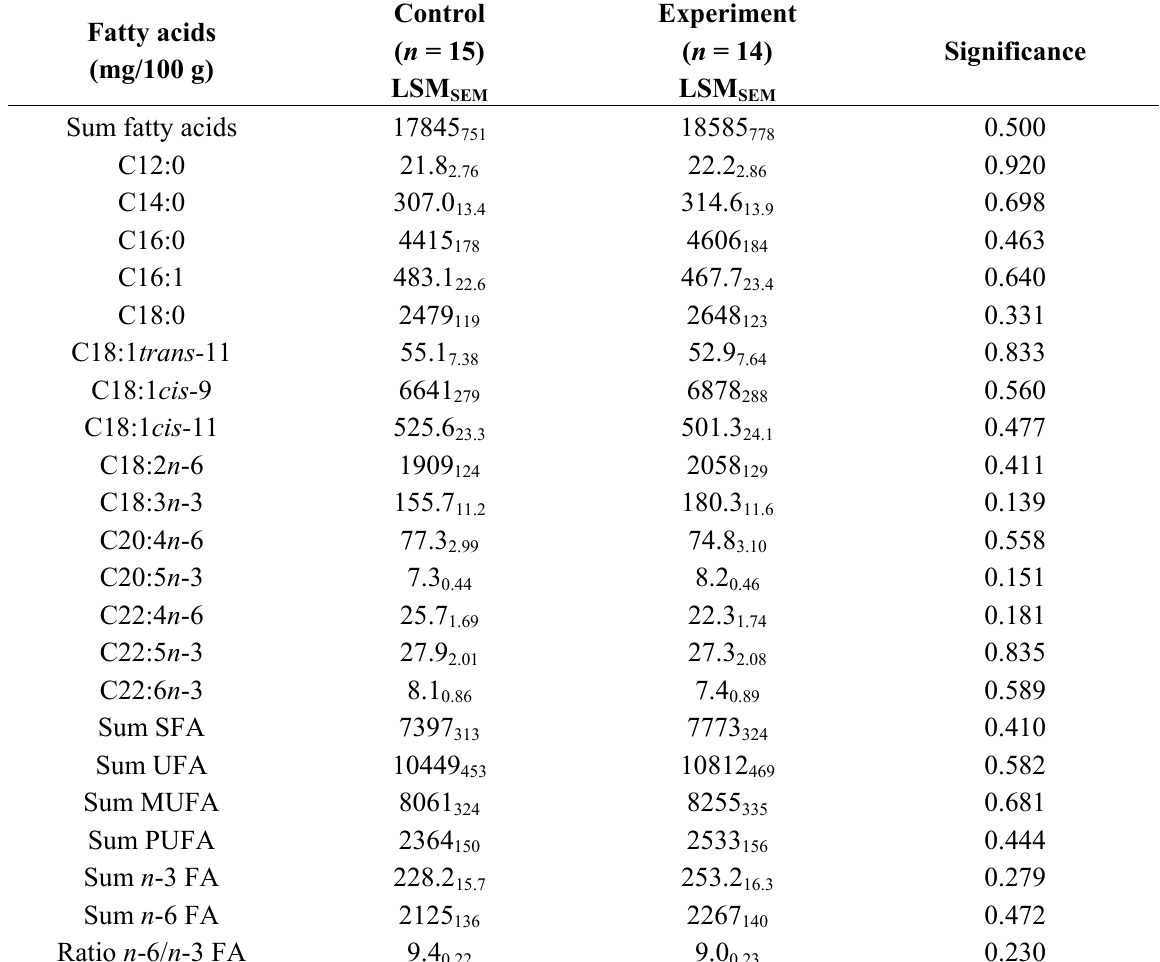
Table 4. Fatty acid concentration (mg/100 g) of scalded sausage produced from meat sections of German Holstein bulls fed a different